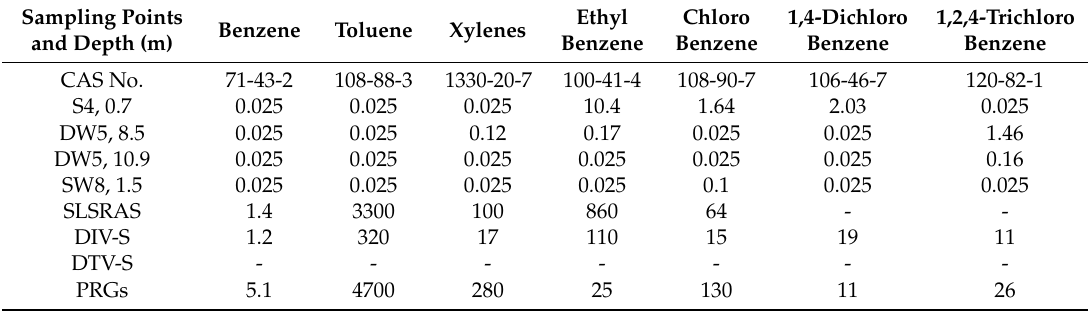
Table 1. Contaminants in soil samples from the Luhe site, China (Unit: mg/kg in dry weight). Sampling Points and Depth